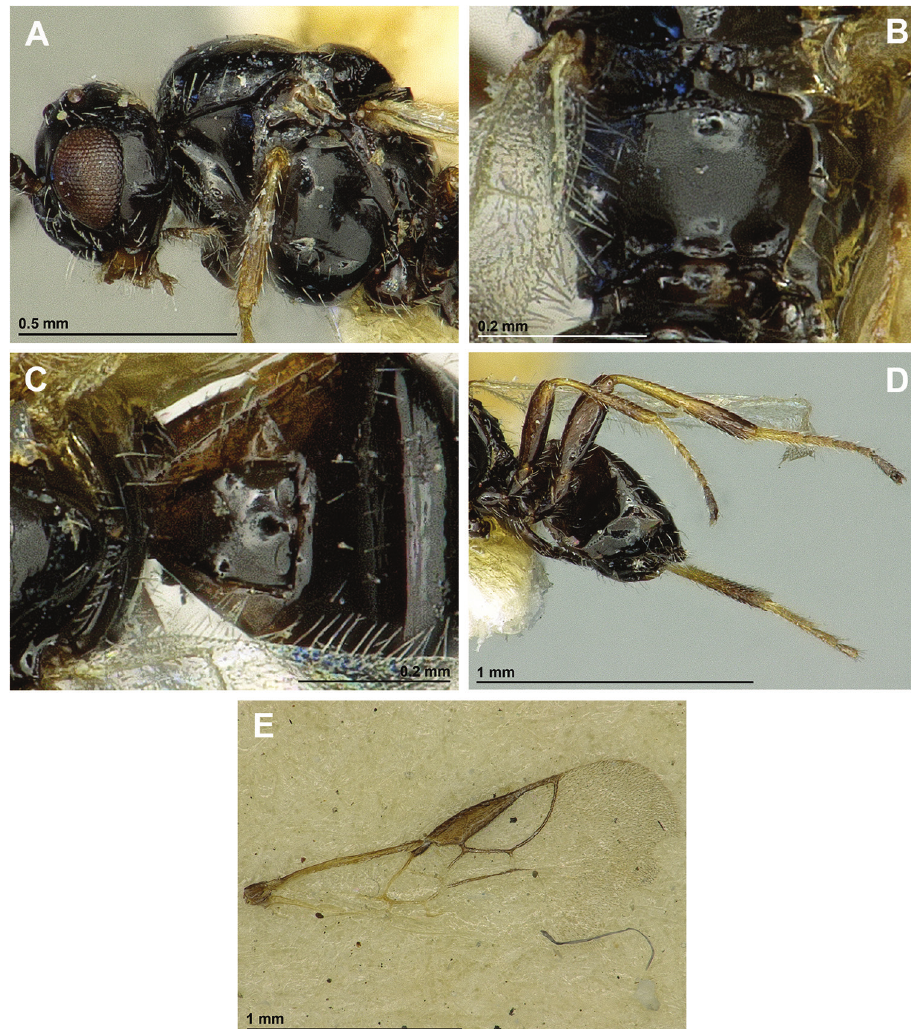
Figure 4. Hoplocrotaphus mongolicus Fischer, 1971 (female, holotype) A Head and mesosoma, lateral view B Propodeum, dorsal view C First metasomal tergite D Legs, metasoma and ovipositor, lateral view E Fore